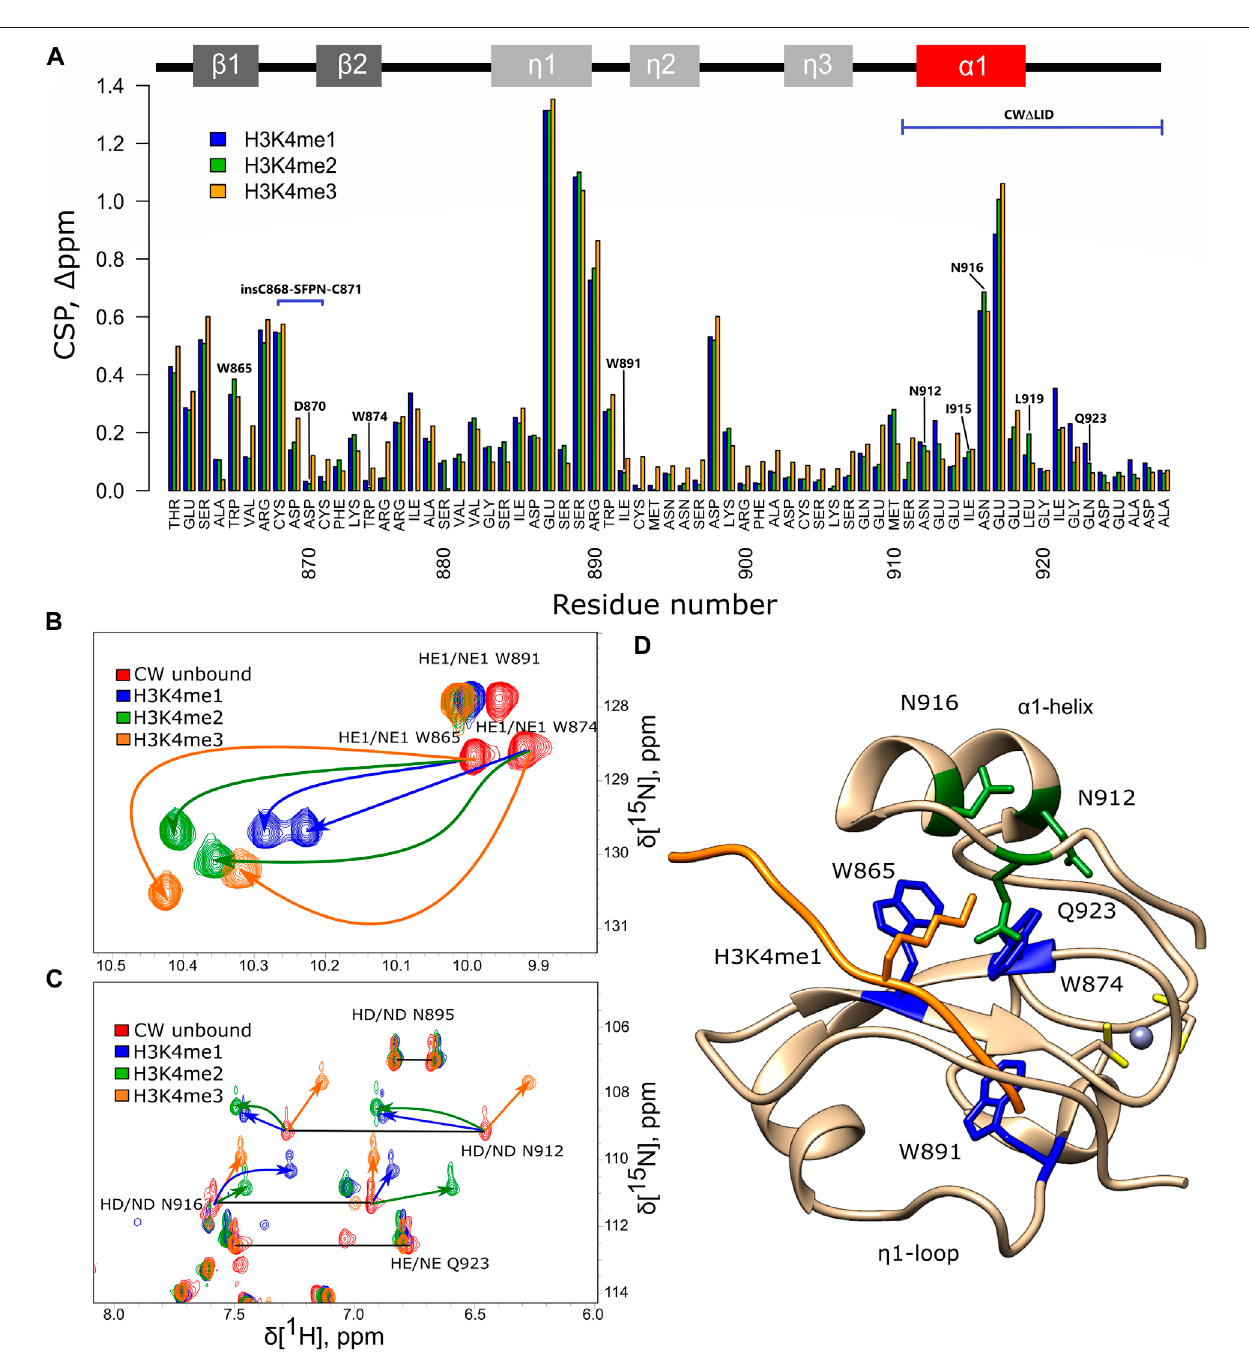
FIGURE 2 | NMR analysis of CW interacting with histone-mimicking peptides. (A) Chemical shift perturbation, calculated for CW bound to the corresponding peptides (H3K4me1 blue, H3K4me2 green, and H3K4me3 orange). Secondary structure of CW is indicated at the top of the panel; (B,C) chemical shift of tryptophan, asparagine,andglutamineside-chainsignalsunderbindingofH3K4me1(blue),H3K4me2(green),andH3K4me3(orange)peptides(redcolor — CWdomaininunbound state); horizontal black lines connect signal pairs for 15 N ε and 15 N δ signals of glutamines and aspargines, respectively; and (D) side-chain tryptophans (highlighted in blue), asparagines, and glutamine (highlighted in green) mapped on the CW structure in bound to H3K4me1 peptide (orange color) conformation (PDB: 6QXZ ); grey sphere is the Zn 2+ ion coordinated by cysteins (yellow). All samples were dissolved in NMR buffer (20 mM phosphate buffer pH 6.4, 50 mM NaCl, and 1 mM DTT) with 10% D 2 O at 200 µM concentration of CW. The CW-to-peptide ratios were 1:4 for H3K4me1, 1:6 for H3K4me2, and 1:10 for H3K4me3.